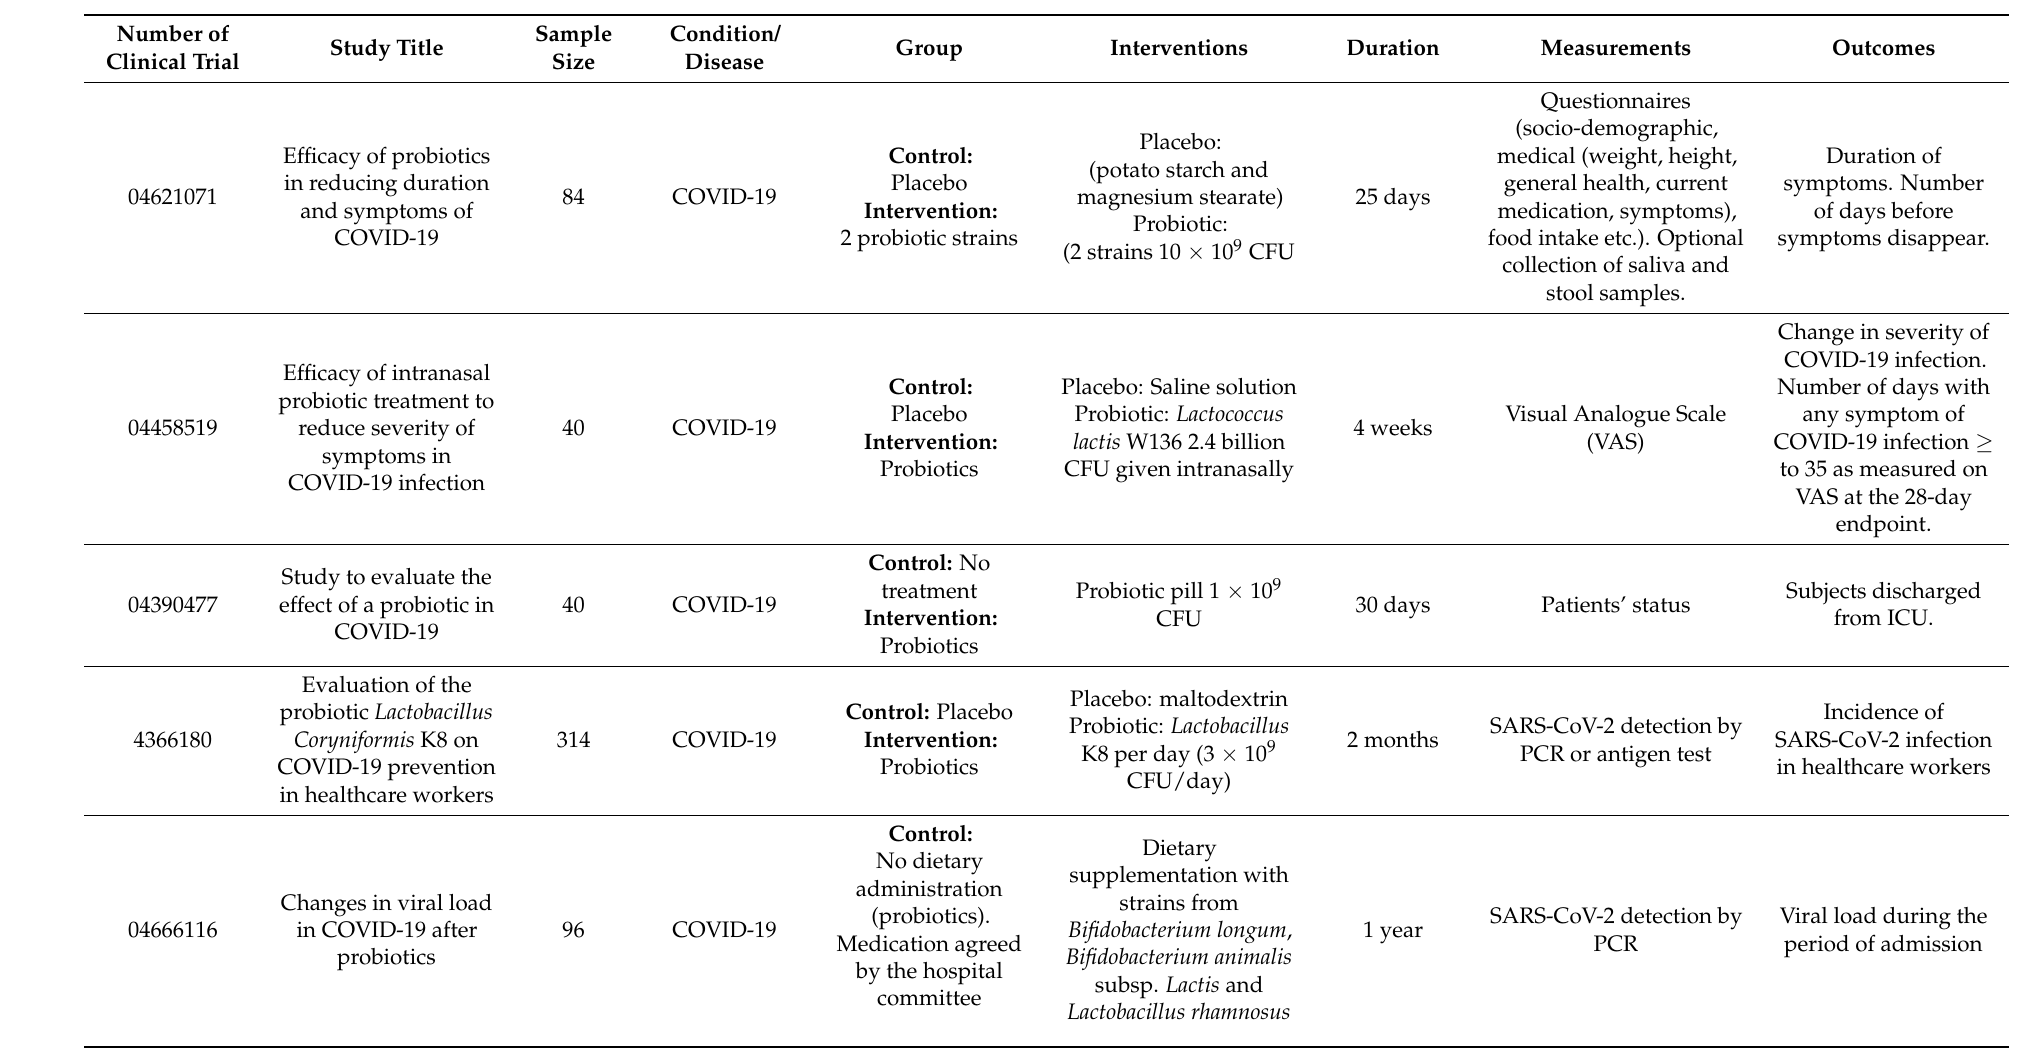
Table 2. Ongoing in vivo studies evaluating probiotic treatment in patients with COVID-19 infection (ClinicalTrials.gov accessed on 31 December